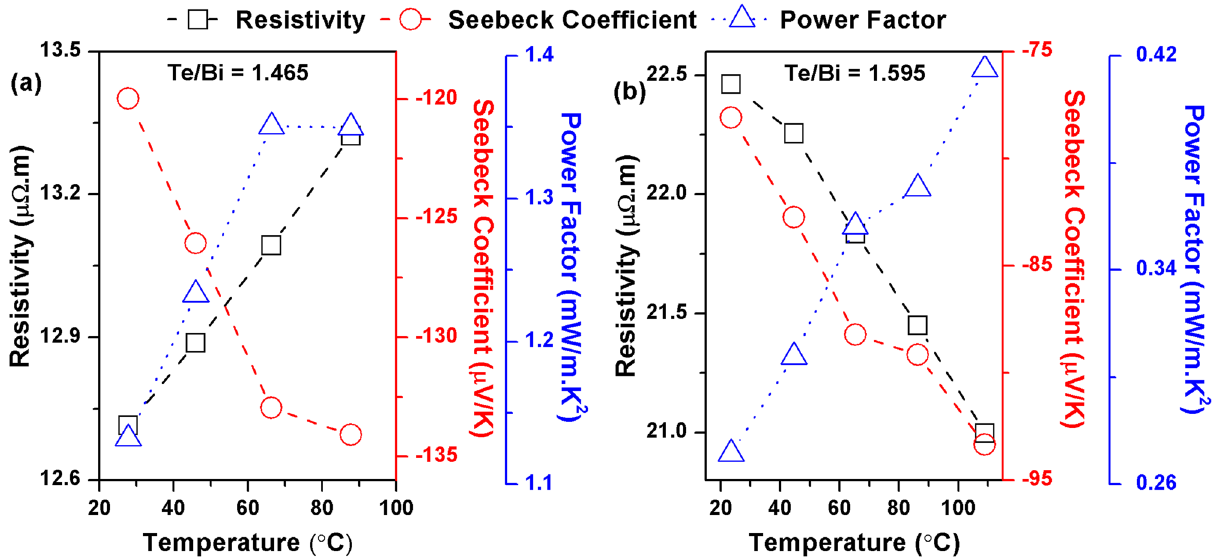
Figure 11. The temperature dependence of the thermoelectric properties of the best Bi–Te thin